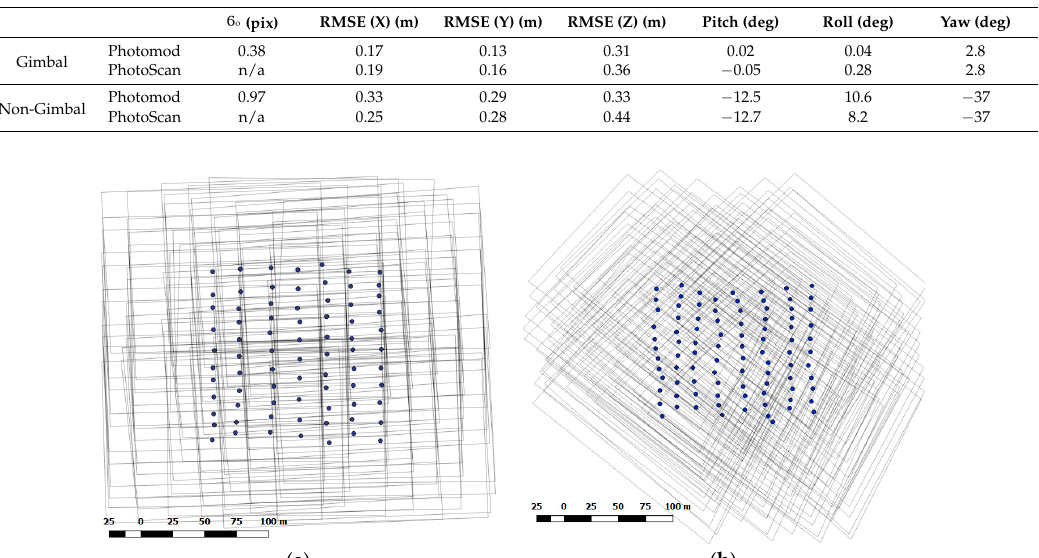
Table 1. Results of bundle-block adjustments of two flights, where: Ϭ o —the overall accuracy of the photogrammetric measurements; RMSE—root mean square errors based on ground control point (GCP) measurements; pitch, roll and yaw—mean sensor orientation angles.